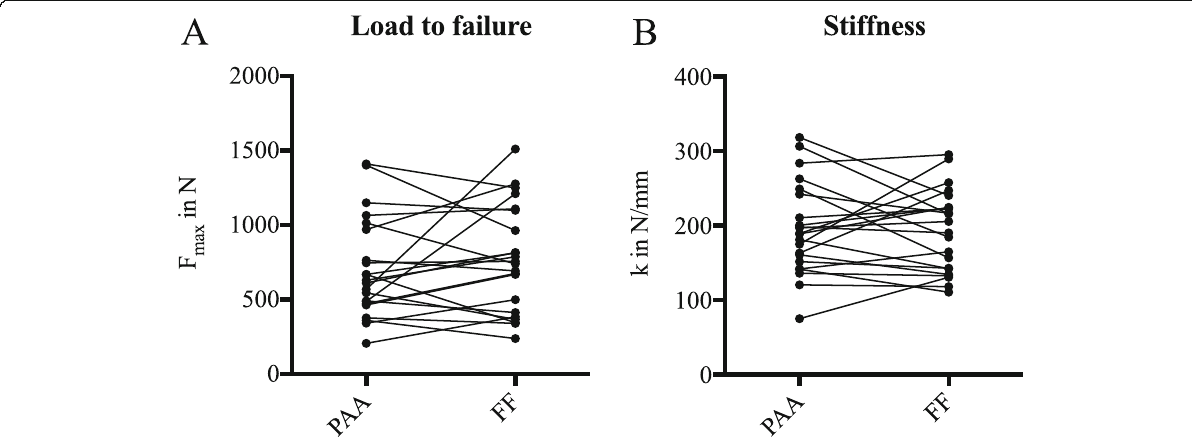
Fig. 4 Meniscus pairs of 22 donors were analysed for failure properties. Menisci that were still attached to a tibial bone block, were fixed in a novel device to mimic physiological load distribution. Following 10 preconditioning cycles, stiffness ( a ) and load to failure ( b ) were determined comparing PAA sterilised menisci to their untreated controls